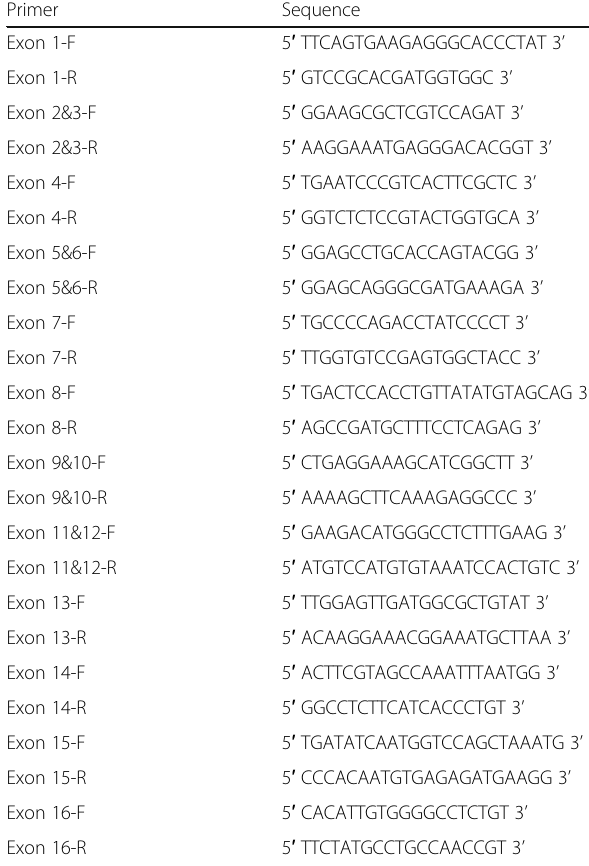
Table 1 Primer sequences of exons of the PDE3A gene Primer Sequence